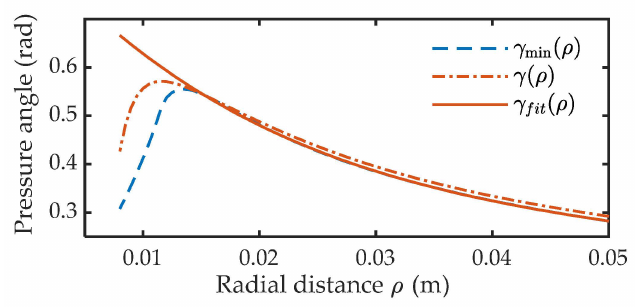
Figure 6. Numerical synthesis of the cam pitch curve pressure